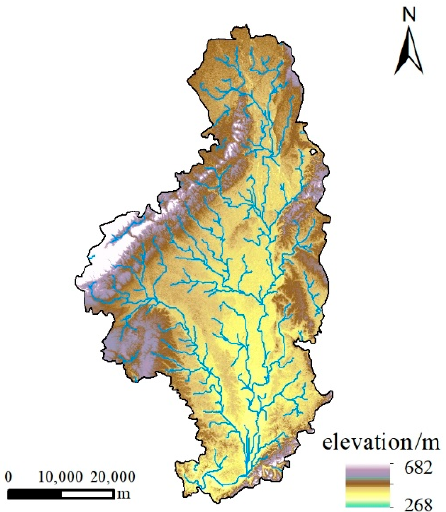
Figure 1. Actual river network in the water source area of Tongjiyan.